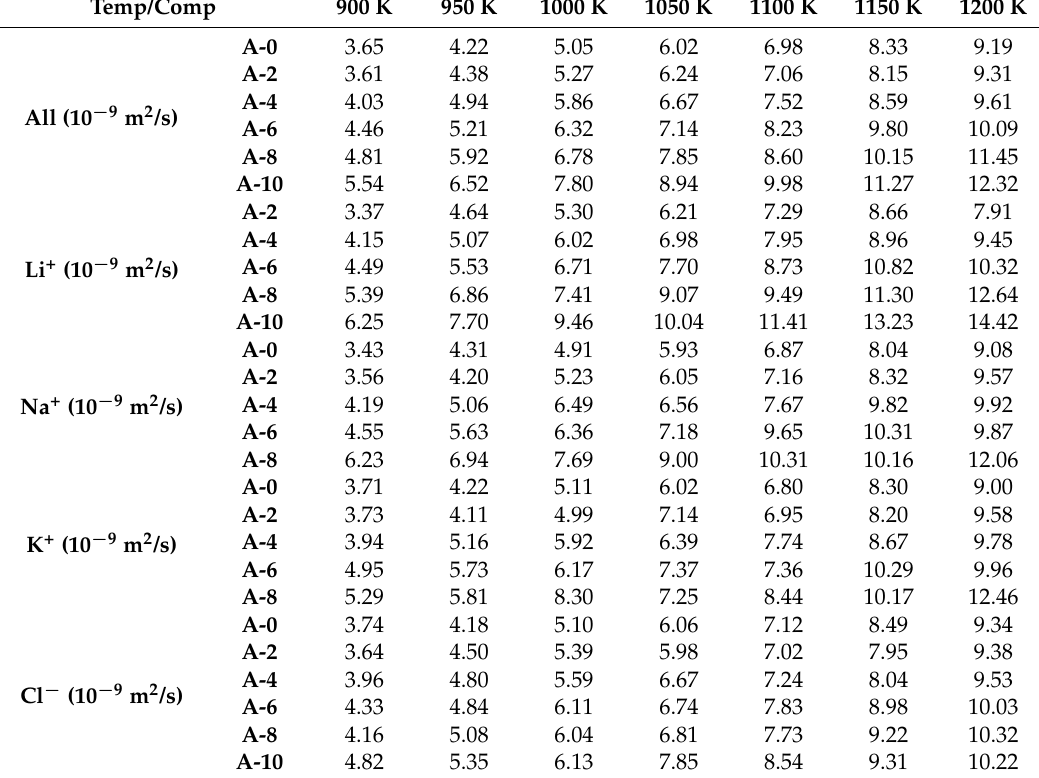
Table 5. Self-diffusion coefficients for six typical compositions at various temperatures. Temp/Comp